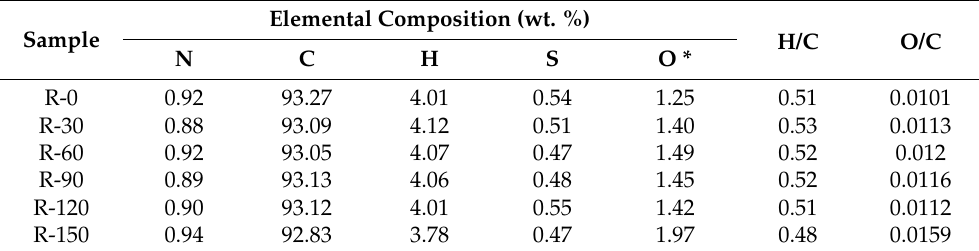
Table 2. Elemental compositions of spinnable pitch at different incubation days.